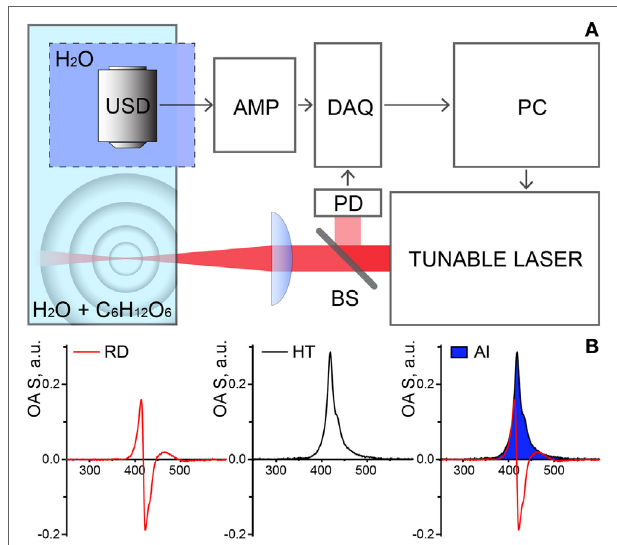
FIGURe 1 | (A) Schematic representation of the experimental setup for optoacoustic spectroscopy (OAS). Abbreviations: USD, ultrasound transducer; DAQ, data acquisition card; PD, photodiode; BS, beam splitter; AMP, amplifier; PC, personal computer. (B) Stages of the data processing and analysis. OAS raw data (RD, left) is transformed with Hilbert transformation (HT, middle) and the area of interest (AI, right—in blue) under curves were taken as the measure of the OAS signal ( I OA